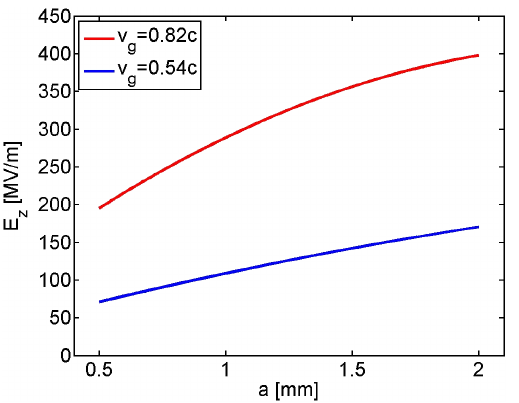
FIG. 7. Maximum acceleration gradient as a function of the radius in the DWA linac for a different group velocity case. v 0 . 82 c and v ¼ 0 . 54 c cases are corresponding to b=a ¼ 1 . 06 and g b=a ¼ 1 . 2 ,